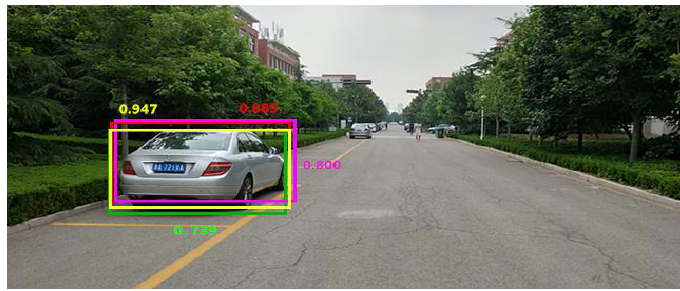
Figure 7. Processing time for each step of the inspection system (in ms).